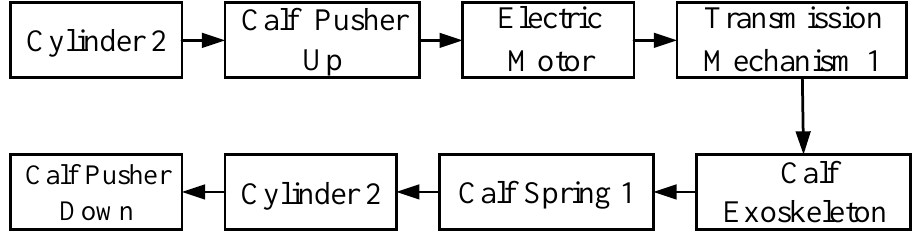
Figure 3. The rehabilitation training process of the knee